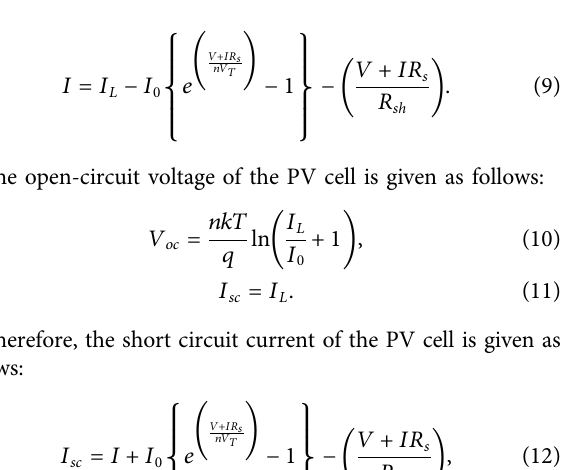
FIGURE 2 | ENN-based tri-port converter block